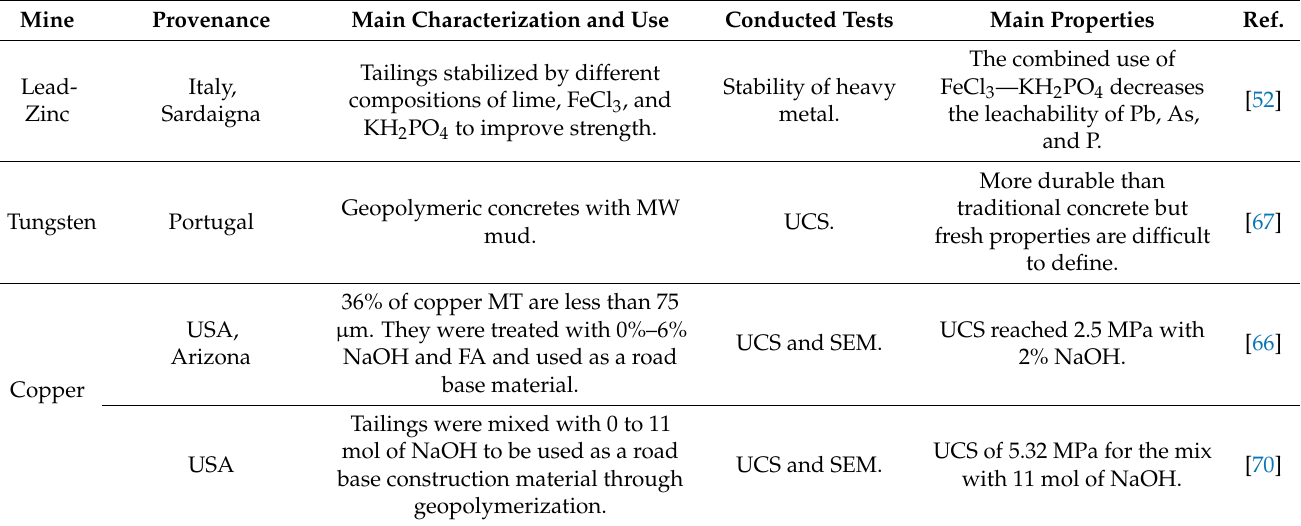
Table 4. Mine wastes used in road construction—geopolymerization